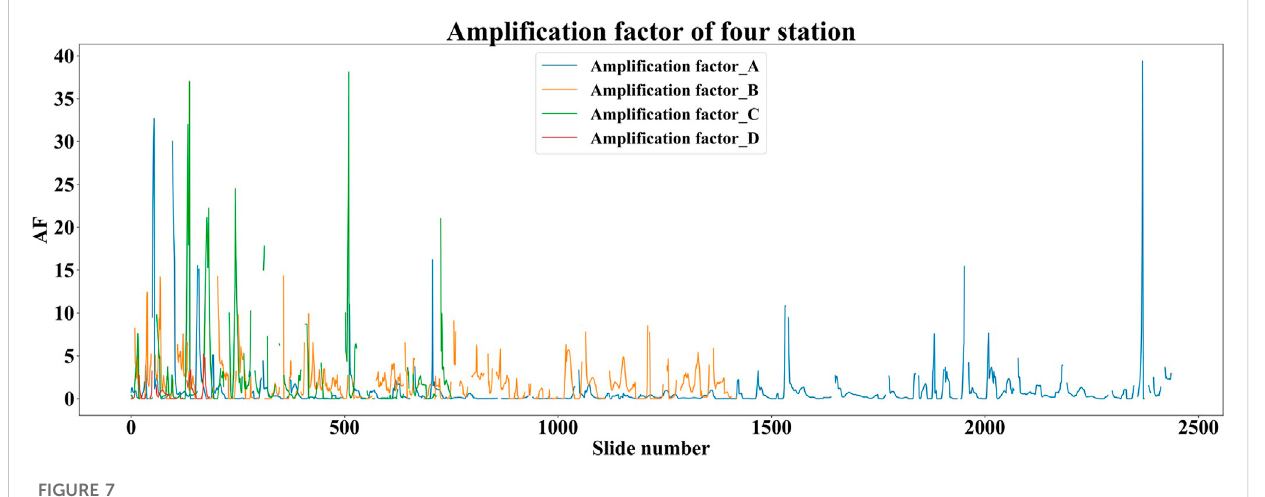
FIGURE 7 Results of ampli fi cation factors for the four stations.